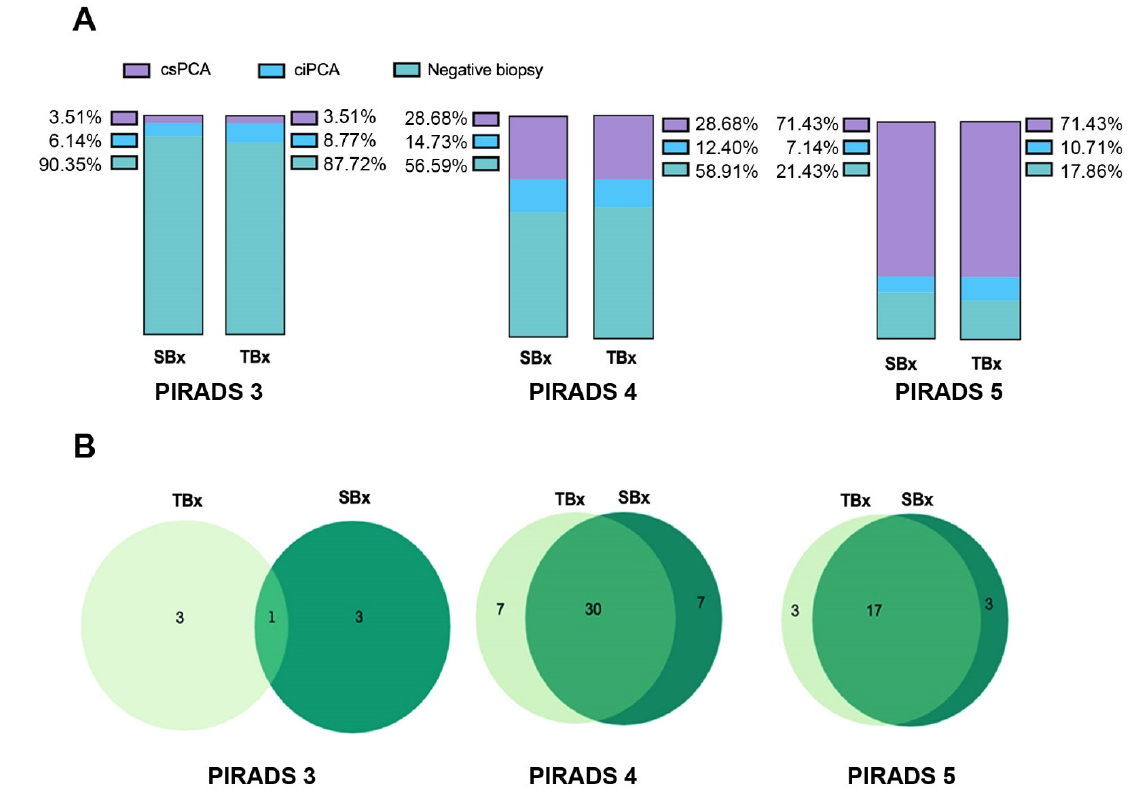
Figure 2. Diagnostic accuracy of TBx and SBx. ( A ) Percentages of patients with csPCa, ciPCa, or with negative biopsy revealed by TBx or SBx according to the PIRADS v2 score. ( B ) Venn diagrams showing the number of csPCa detected by TBx alone, SBx alone, or by the combined TBx/SBx approach.